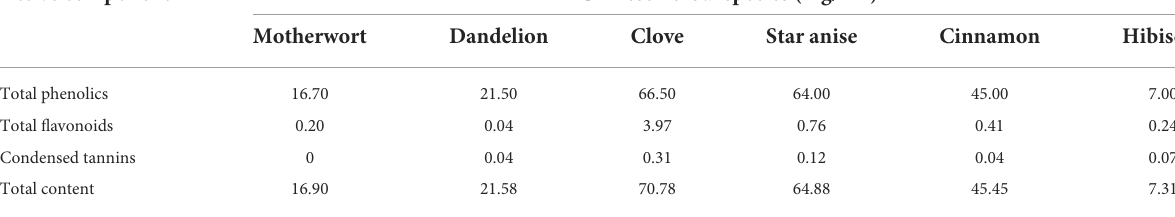
TABLE 1 Active components of alcohol extracts from six Chinese herbal medicines. Active